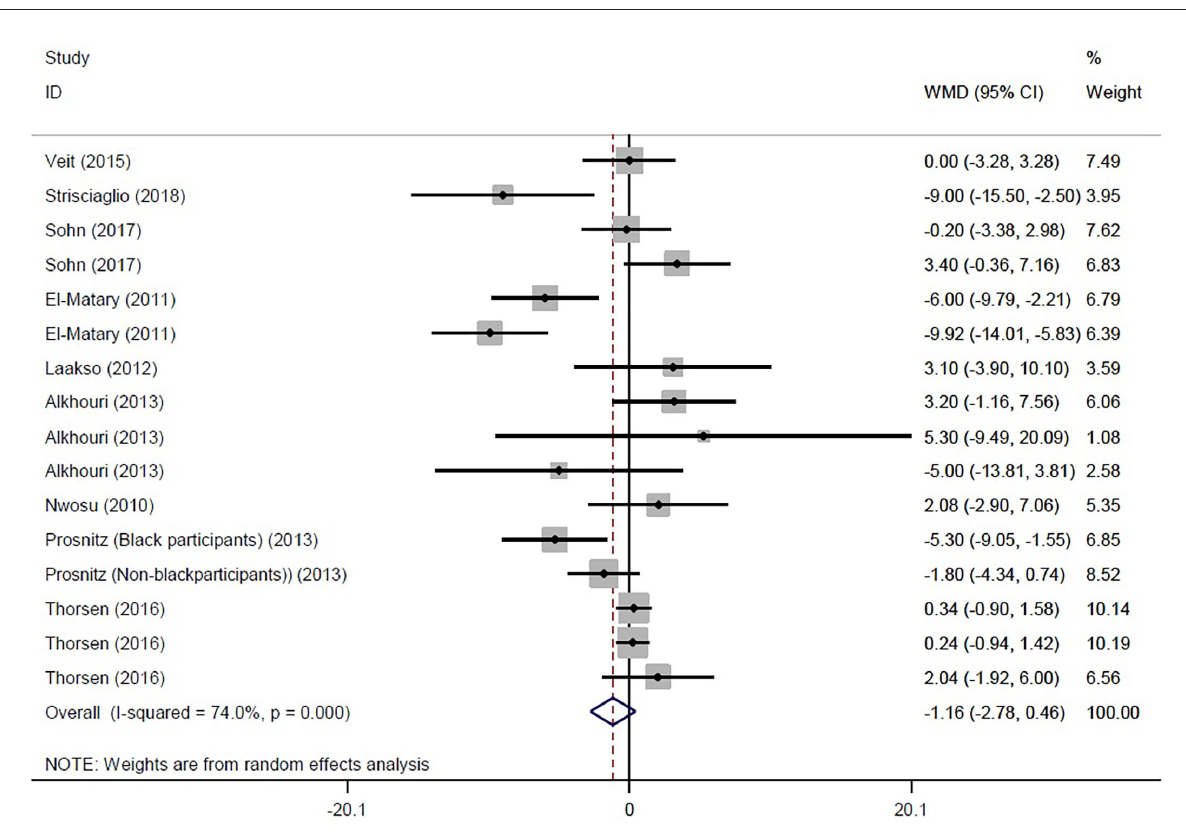
FIGURE2 Forest plot show the WMD in serum vitamin D concentrations between participants with IBD and healthy